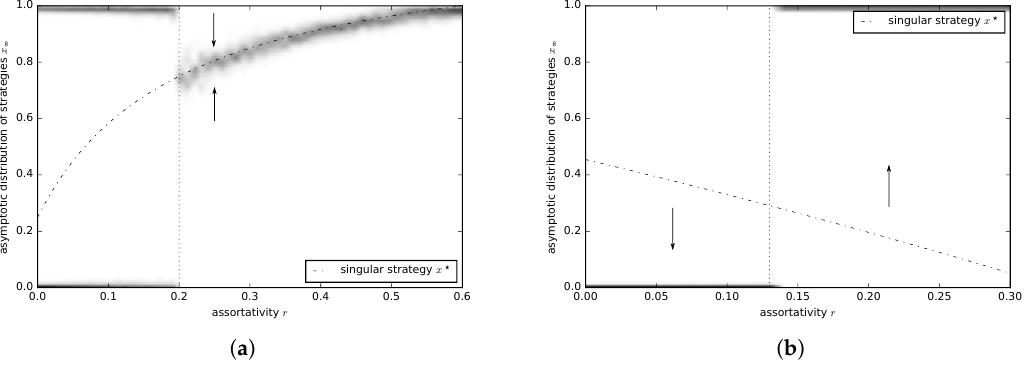
Figure 9. Variation of the distribution of asymptotic strategy values x ∞ with assortativity r , in a CSD game with quadratic cost function and quadratic benefit function. ( a ) C ( x ) = − 1.6 x 2 + 4.8 x and B ( x ) = − x 2 + 5 x , and ( b ) C ( x ) = − 1.5 x 2 + 4 x and B ( x ) = − 0.2 x 2 + 3 x . Parameters: n = 10,000, x 0 = 0.3, x m = 1, µ = 0.01, σ = 0.005, and β = 1. Arrows indicate the direction of evolutionary change.